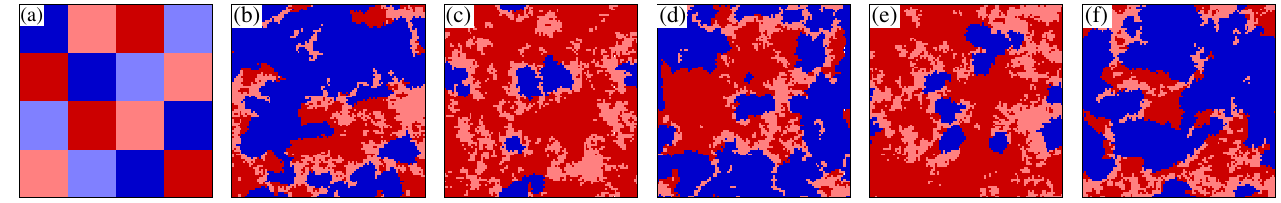
FIG. 6. Representative spatial evolution of the four competing strategies from a prepared initial state towards the three-strategy þ P D þ P phase that is sustained by cyclic dominance. Note that blue and red colors dominate cyclically over the course of 16 000 D C MCS from left to right. The colors used are the same as in Figs. 4 and 5. Depicted are snapshots of the square lattice, as obtained for β ¼ 0 . 52 , γ ¼ 0 . 065 , and r ¼ 3 . Since a prepared initial state is used, a small square lattice with linear size L ¼ 100 can be used for